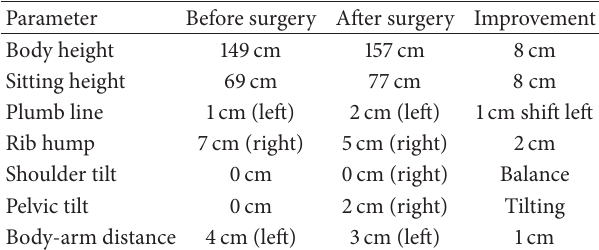
Table 1: Physical examination parameters before and after